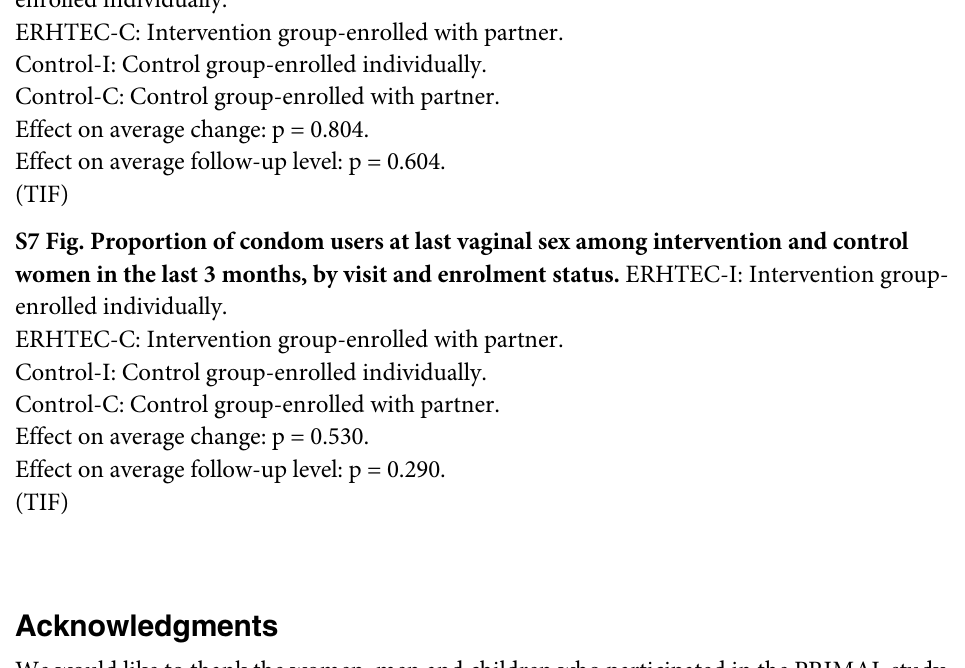
S5 Fig. Proportion of consistent or intermittent condom users among intervention and control women in the last 3 months, by visit and enrolment status. ERHTEC-I: Intervention group-enrolled individually.